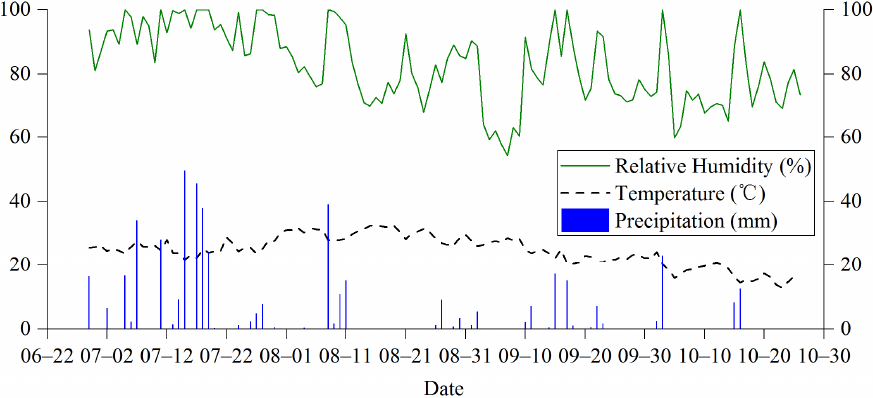
Figure 2. The relative humidity, temperature and precipitation during the rice growing season.